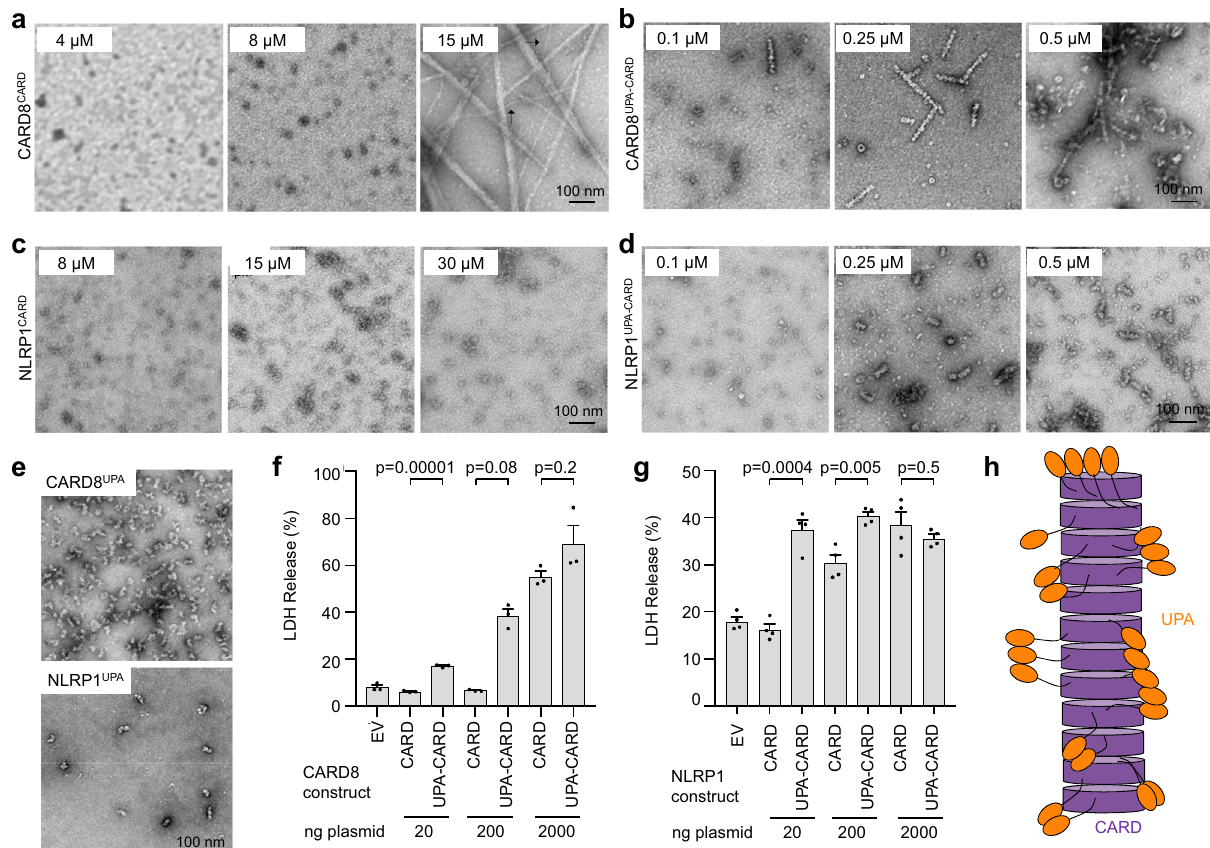
Fig. 3 The UPA subdomain reduces the concentration required for in fl ammasome formation. a , b Concentration-dependent formation of CARD8 CARD ( a ) and CARD8 UPA-CARD ( b ) fi laments, visualized by negative staining EM. Puri fi ed monomeric MBP-fused proteins were cleaved at concentrations ranging from 0.1 to 15 µ M. CARD8 CARD fi laments did not appear consistently until 15 µ M. CARD8 UPA-CARD fi laments formed consistently at 0.25 µ M. Arrows in a indicates single, unbundled fi laments. c , d Concentration-dependent formation of NLRP1 CARD ( c ) and NLRP1 UPA-CARD ( d ) fi laments. Puri fi ed